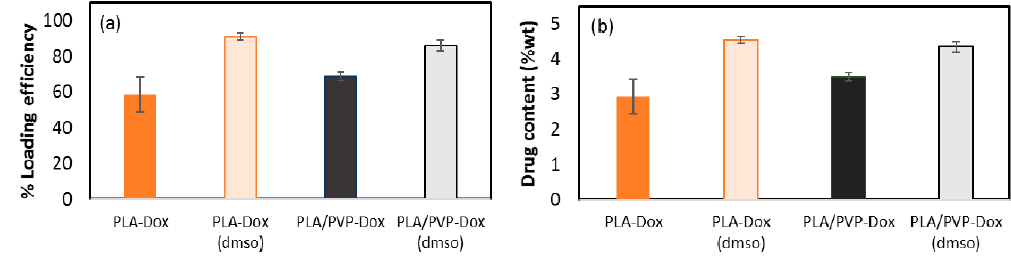
Figure 7. Loading content ( a ) and loading efficiency ( b ) of doxorubicin in the web.